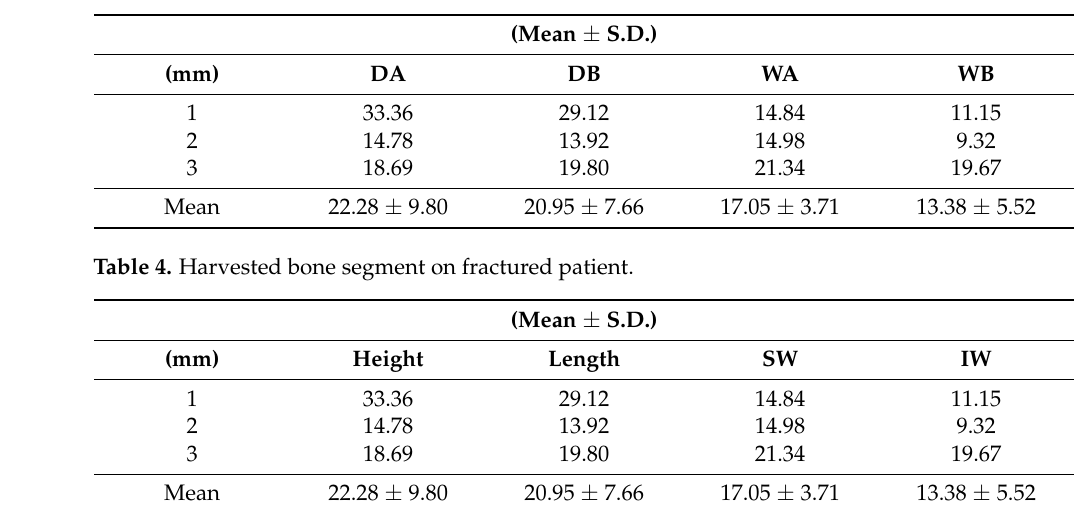
Table 3. Distance measurement on fractured patients.